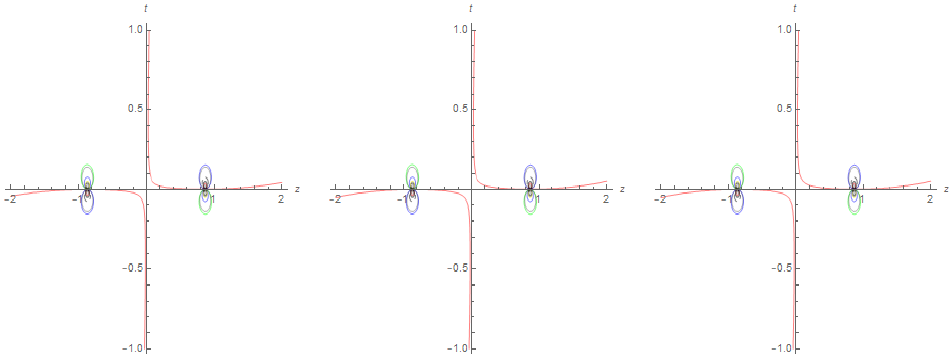
Figure 16. Contour slots for Figure